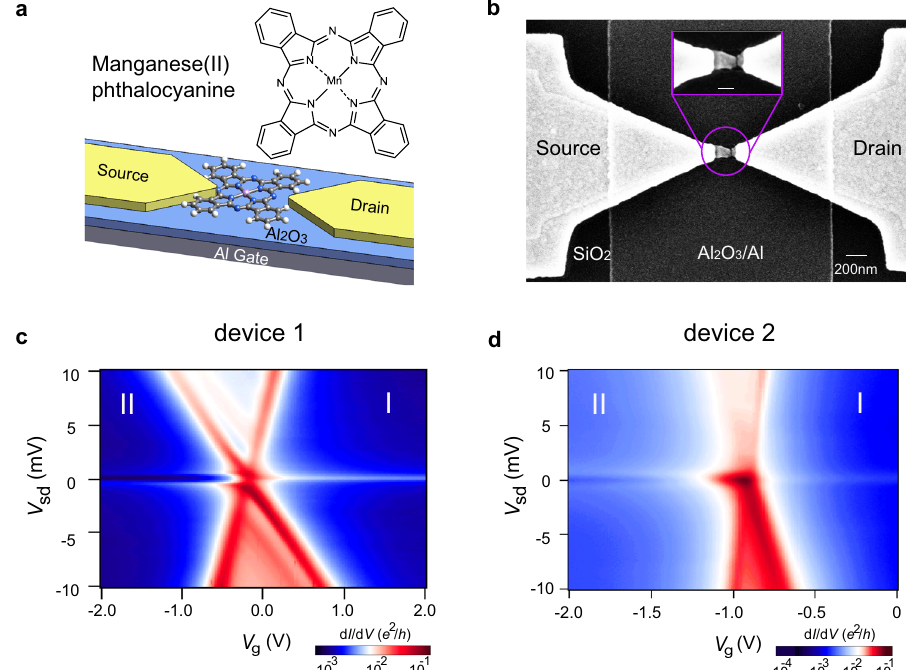
Fig. 1 Device and electron transport spectra. a Structure of Manganese(II) phthalocyanine molecule (MnPC, top), a schematic diagram of a single MnPC molecule transistor device (bottom). b SEM image of the device after breaking: gold nanowire over an Al 2 O 3 /Al gate, a nanogap formed in gold nanowire by electromigration. The scale bar of the inset is 100 nm. c , d Color plots of differential conductance (d I /d V ) as a function of bias voltage ( V sd ) and gate voltage ( V g ) for device 1 at 280 mK ( c ) and device 2 at 1.4 K ( d